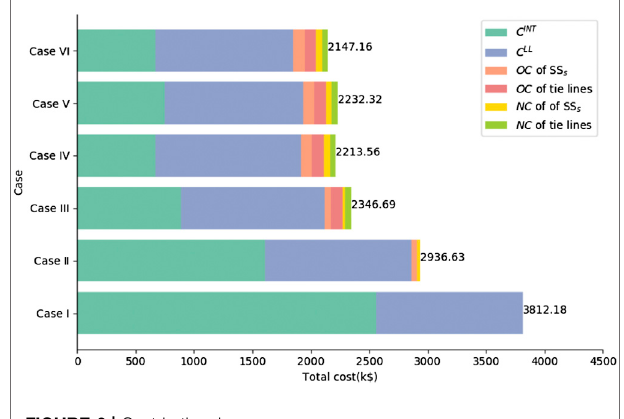
FIGURE 6 | Cost in the six